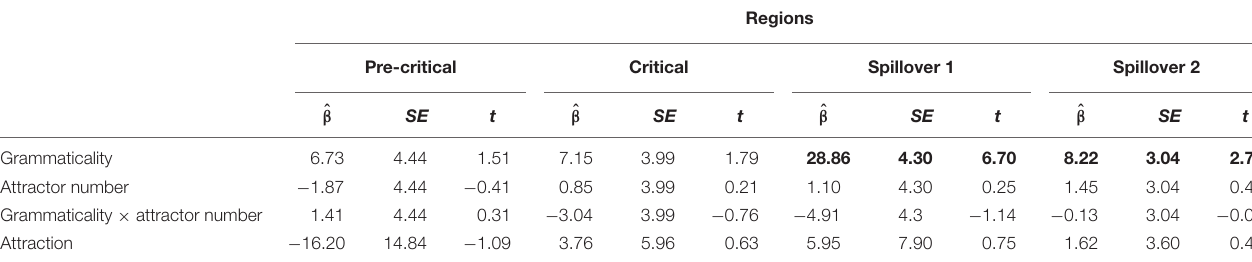
TABLE 9 | Summary of statistical analyses for Experiment 3.